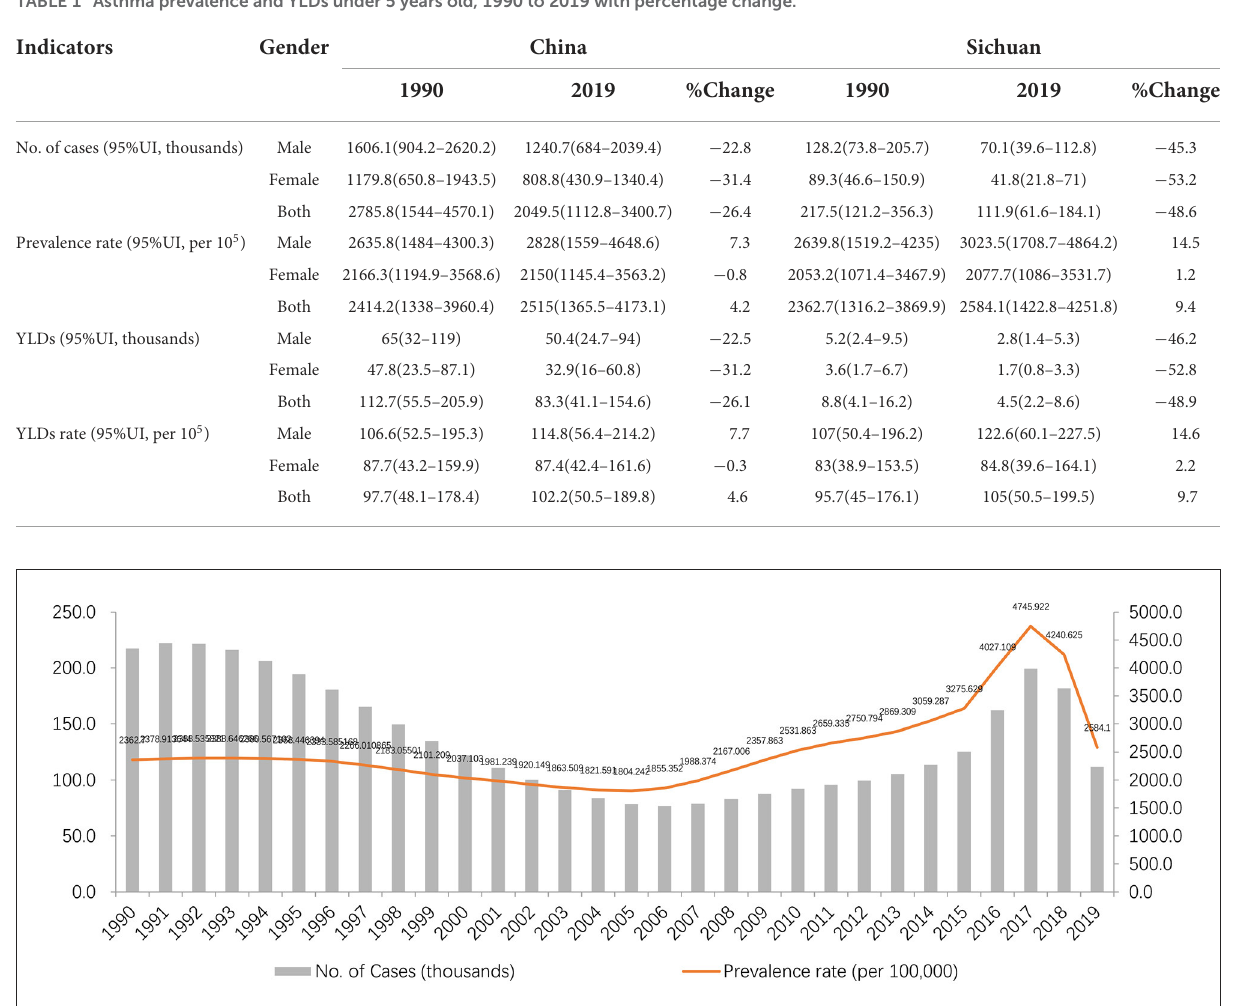
FIGURE1 Time trends of prevalence and the rates attributed to asthma under 5 years old from 1990 to 2019 in